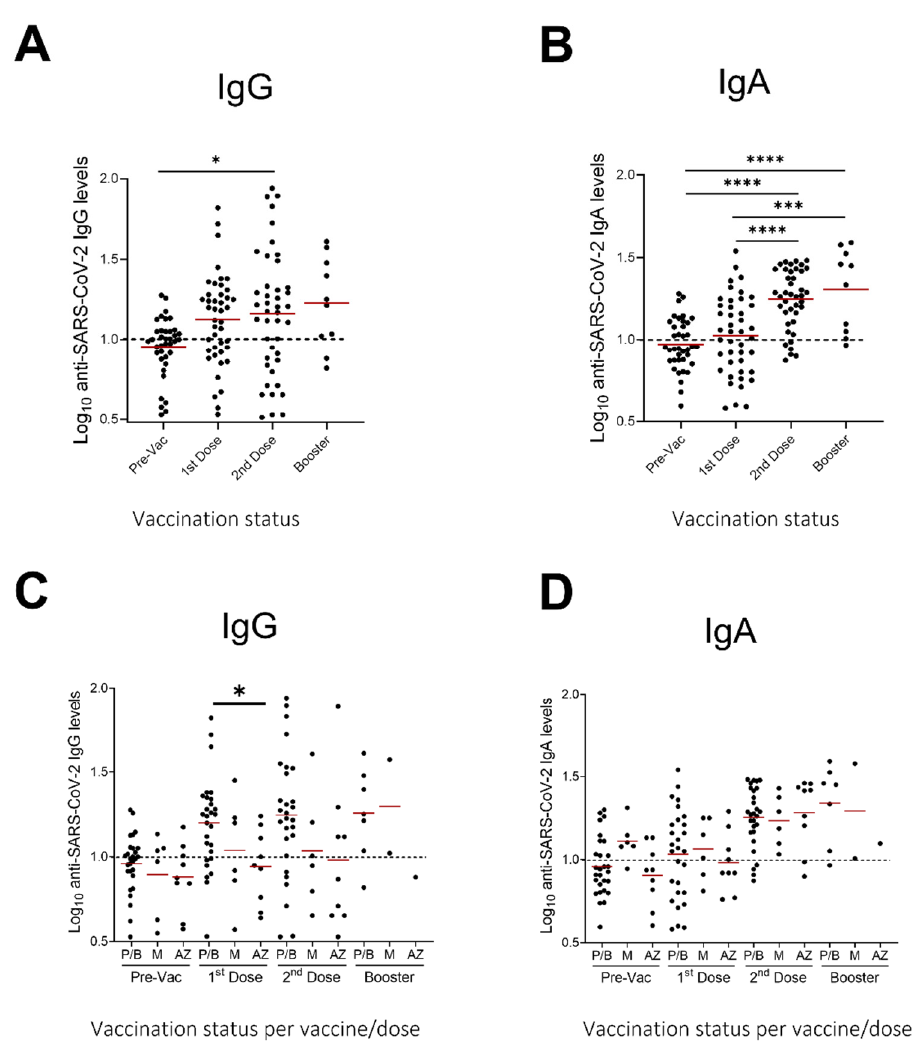
Figure 2. Levels (in relative Units) of anti-SARS-CoV-2 IgG and IgA in human milk samples. SARS- CoV-2 IgG ( A ) and IgA ( B ) antibodies before and after 1st, 2nd, and booster dose of vaccination (all vaccines) and SARS-CoV-2 IgG ( C ) and IgA ( D ) antibodies before and after 1st, 2nd, and booster dose of vaccination (per vaccine type) Dotted lines: positive cut-off values previously determined for each assay as the mean values of negative control (before vaccination) milk samples. Asterisks show statistically significant differences between variables; (* p < 0.05; *** p < 0.001; **** p < 0.0001) using one-way ANOVA followed by Tukey’s multiple comparisons test. P/B: Pfizer/BioNTech, M: Moderna, A/Z: AstraZeneca .